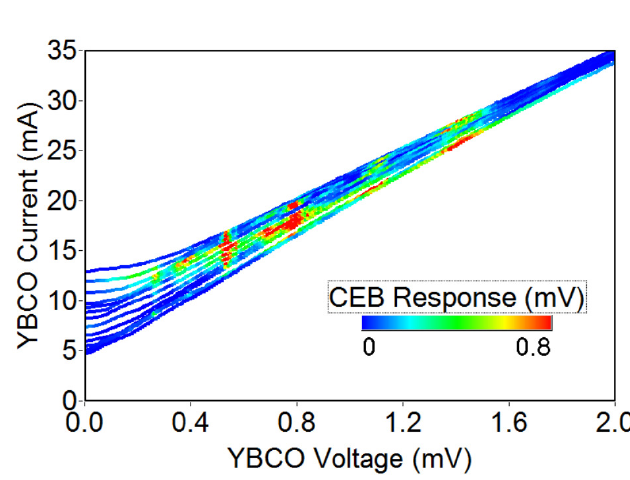
Figure 5. The experimental IV curves of bicrystal junction L = 50 µ m correspond to the increasing magnetic field (from top to bottom). The color indicates the level of CEBs